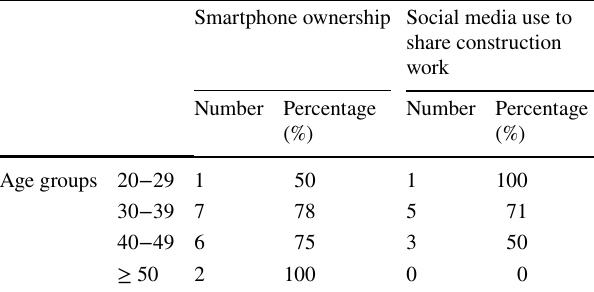
Table 2 Smartphone ownership and social media use for different age groups of masons ( N = 21) in Iringa, Tanzania Smartphone ownership Social media use to share